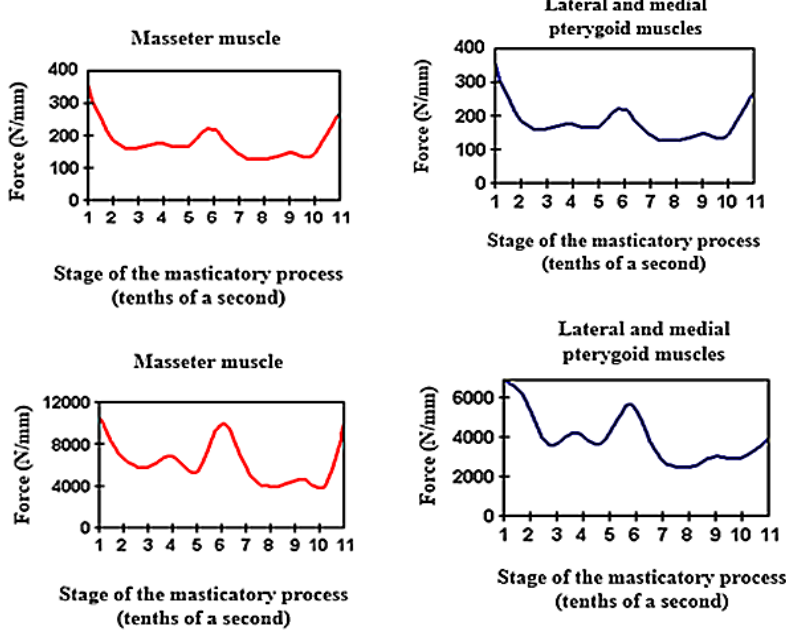
Figure 1. Variation of forces and moments developed by the masseter pterygoid muscles during the masticatory process (a mastication cycle).